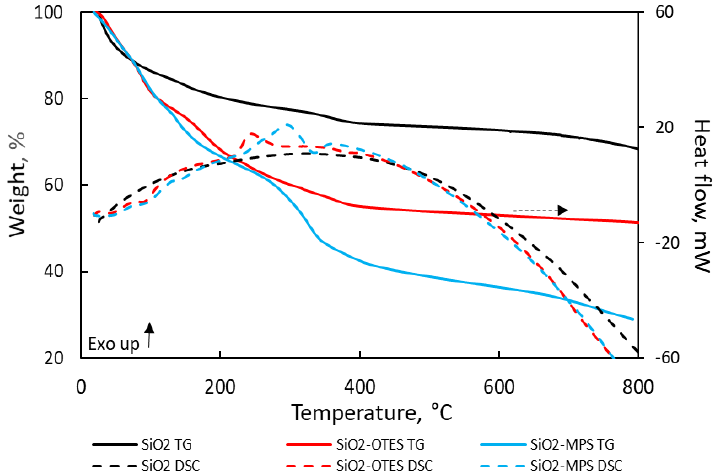
Figure 2. TG/DSC curves of SiO 2 -MPS and SiO 2 -OTES under air atmosphere.